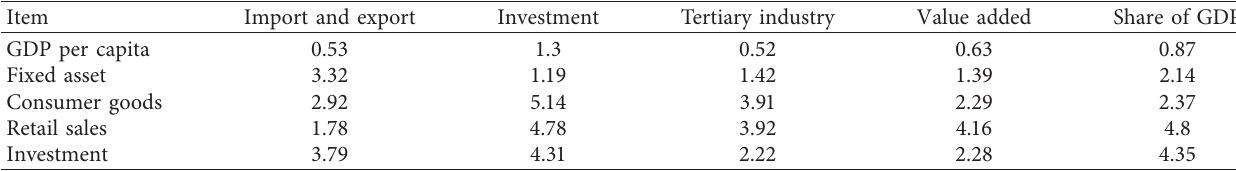
Table 13: High-speed railway economic data in the economic field.